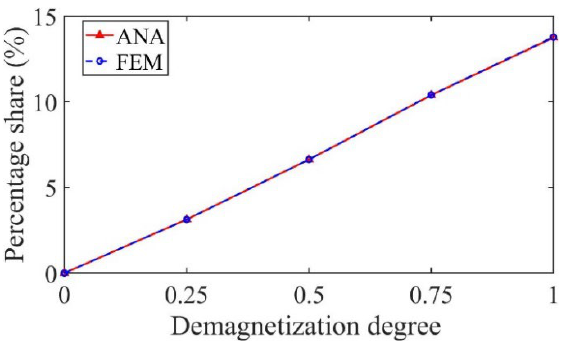
Figure 22. Variation in the percentage share of the harmonic with demagnetization degree.